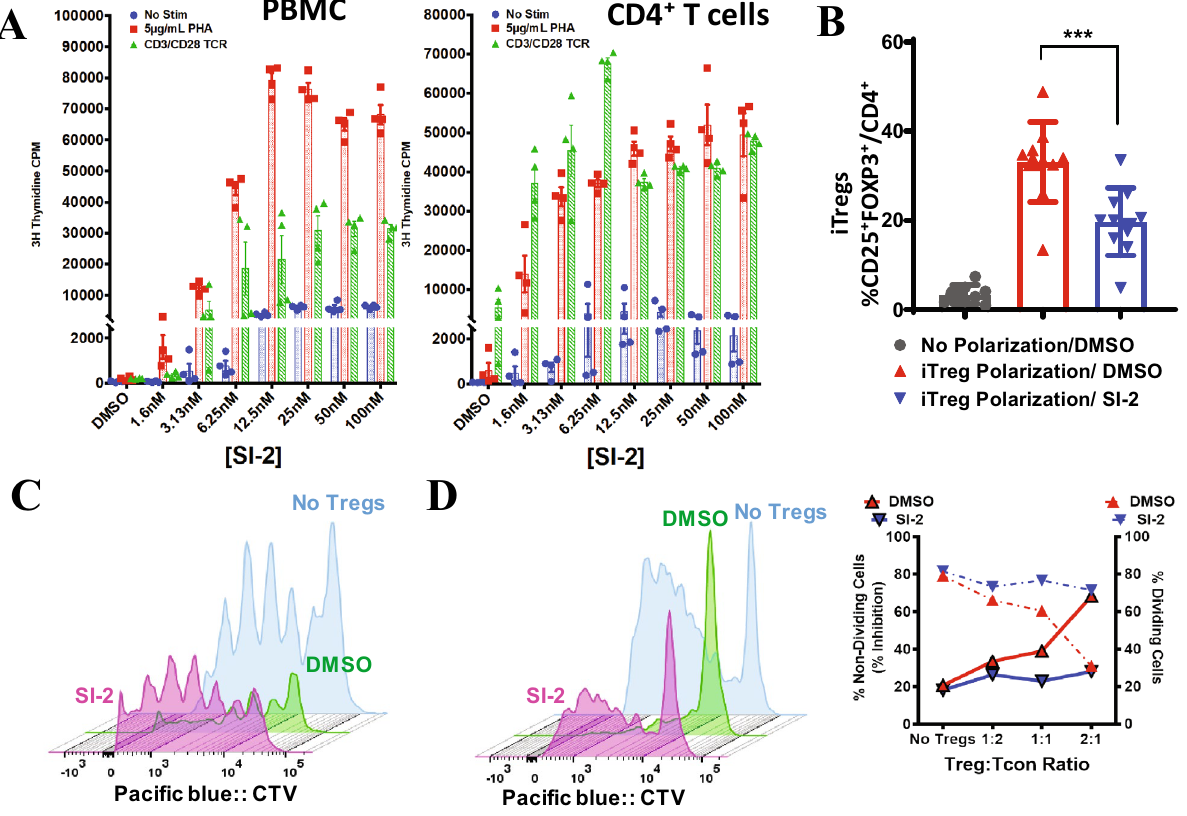
Figure 3. Inhibition of SRC-3 abrogates Treg suppression function. ( A ) Low-dose inhibition of SRC-3 with SI-2 promotes the proliferation of PHA and CD3/CD28 stimulated human PBMC and bulk CD4 + T cells. ( B ) Inhibition of SRC-3 activity in human resting T cells blocks induction into iTregs and ( C ) restricts their ability to suppress proliferating T cells. ( D ) SRC-3 inhibition in Tregs directly isolated from human blood donors relieves their suppressive